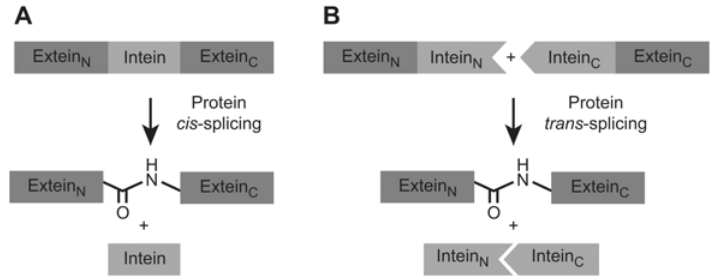
Figure 1 Schematic representation of (A) protein cis- splicing as exerted by bifunctional and mini-inteins, and (B) protein trans -splicing as exerted by split inteins.